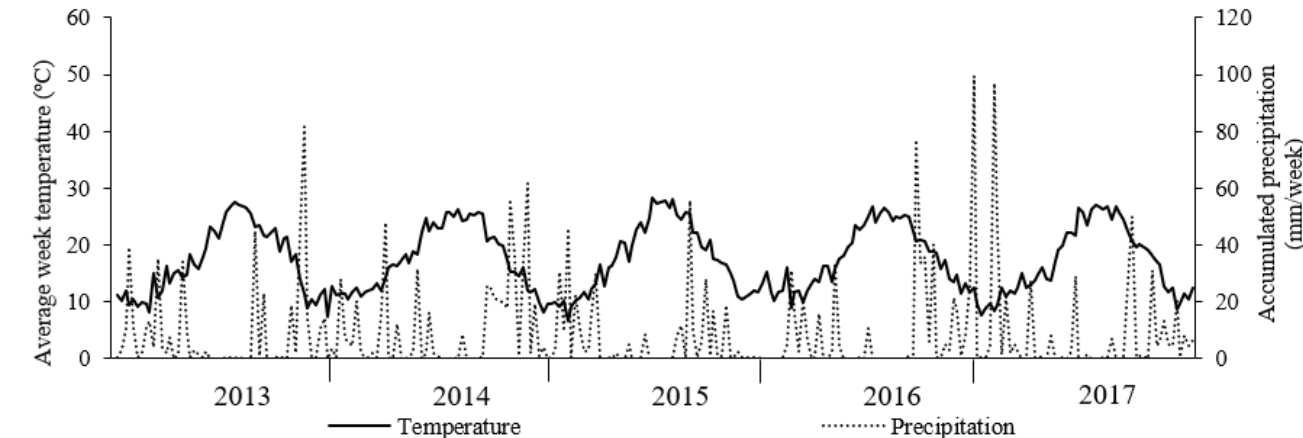
Figure 1. Ombrothermic diagram for the period, showing the average weekly temperature and rainfall.